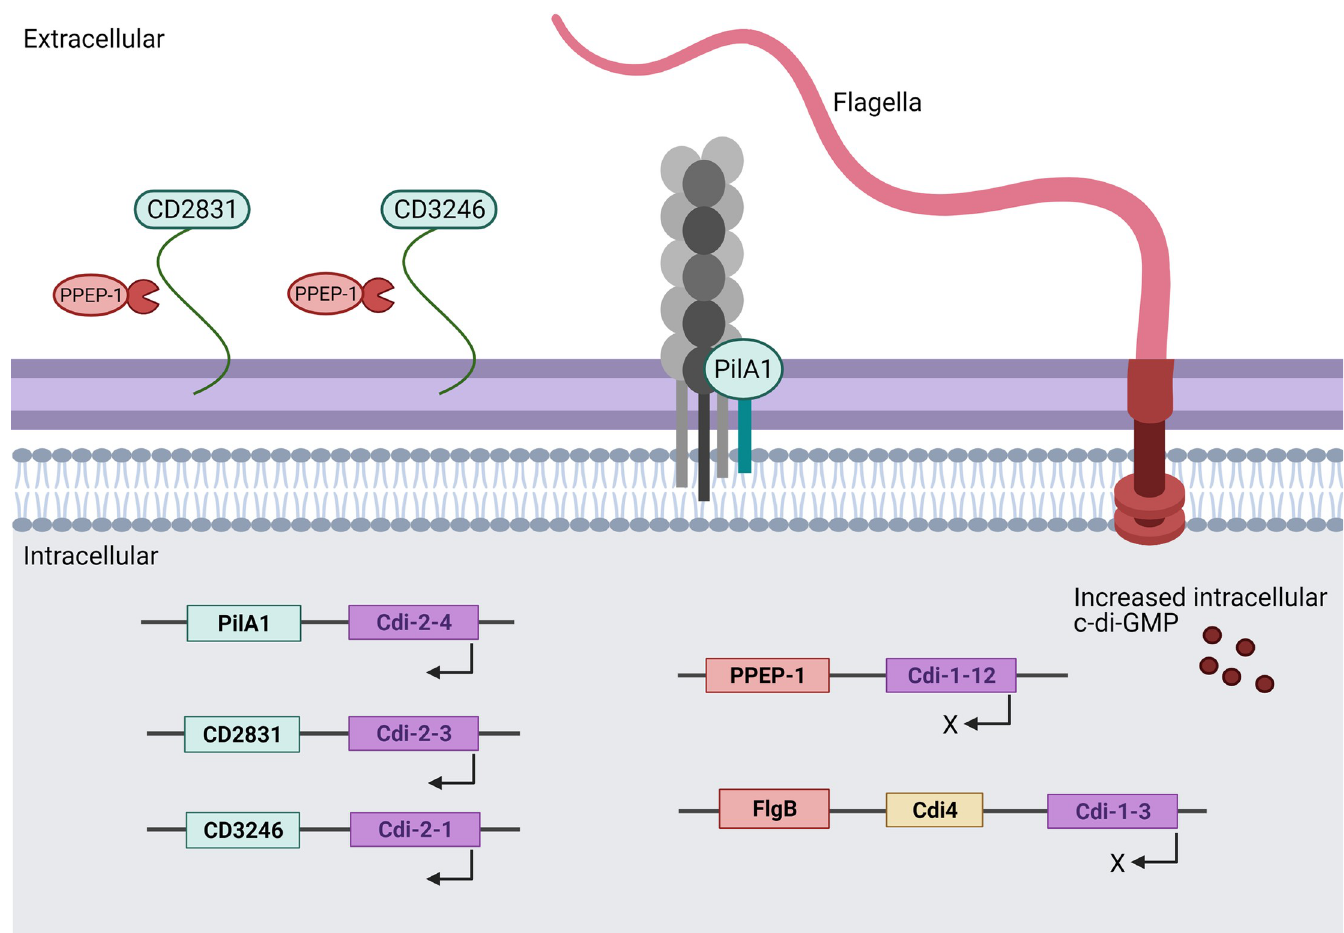
Fig 2. Regulation of cell surface components under high intracellular levels of c-di-GMP acting on specific riboswitches (purple). Down-regulated components in the presence of increased intracellular c-di-GMP are shown in red to include flagella and PPEP-1, which is responsible for cleavage of CD2831 and CD3246. Up- regulated components are shown in green, namely CD2831, CD3246, and PilA1, causing an increase in surface PilA1 structures. Created with BioRender.com. c-di AU : AbbreviationlistshavebeencompiledforthoseusedinFigs 2 and 3 : Pleaseverifythatallentriesarecorrect : - GMP, cyclic diguanosine